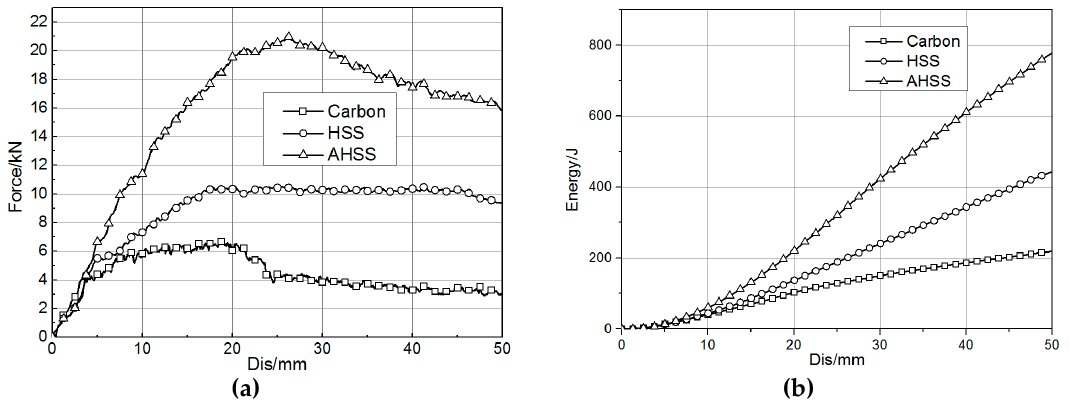
Figure 7. Three-point bending simulation results of steel and carbon fiber. ( a ) Force–displacement curve. ( b ) Energy absorption–displacement curve.